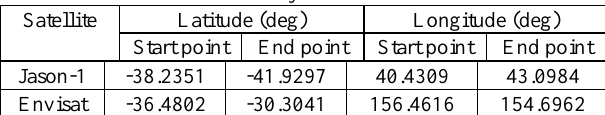
Figure 2, Tsunami lead waves triggered by 2011 Japan’s earthquake and observed by Envisat and Jason-1 altimetry satellites. Table 1. Locations of two Tsunami lead waves observed by two altimetry satellites.